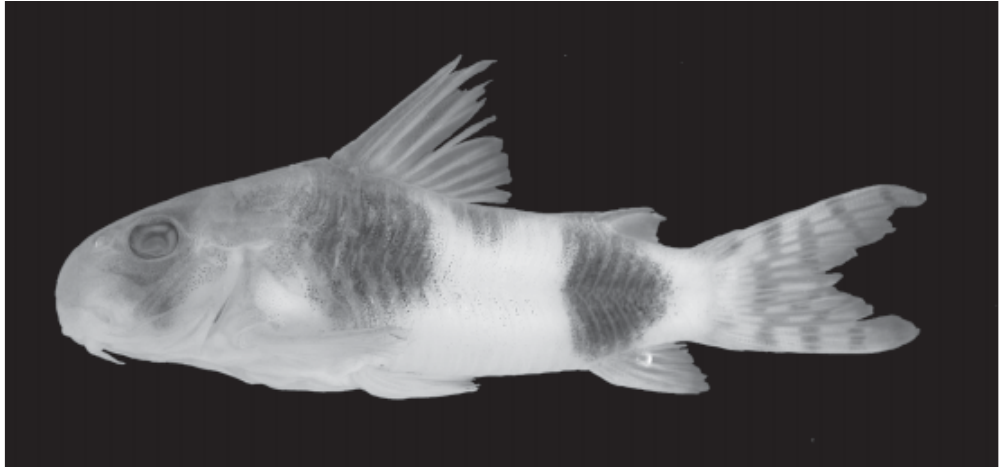
Fig. 2. Corydoras tukano , holotype, MZUSP 82100, presumably a female, 40.9 mm SL; Brazil, estado do Amazonas, rio Tiquié, comunidade de Caruru.